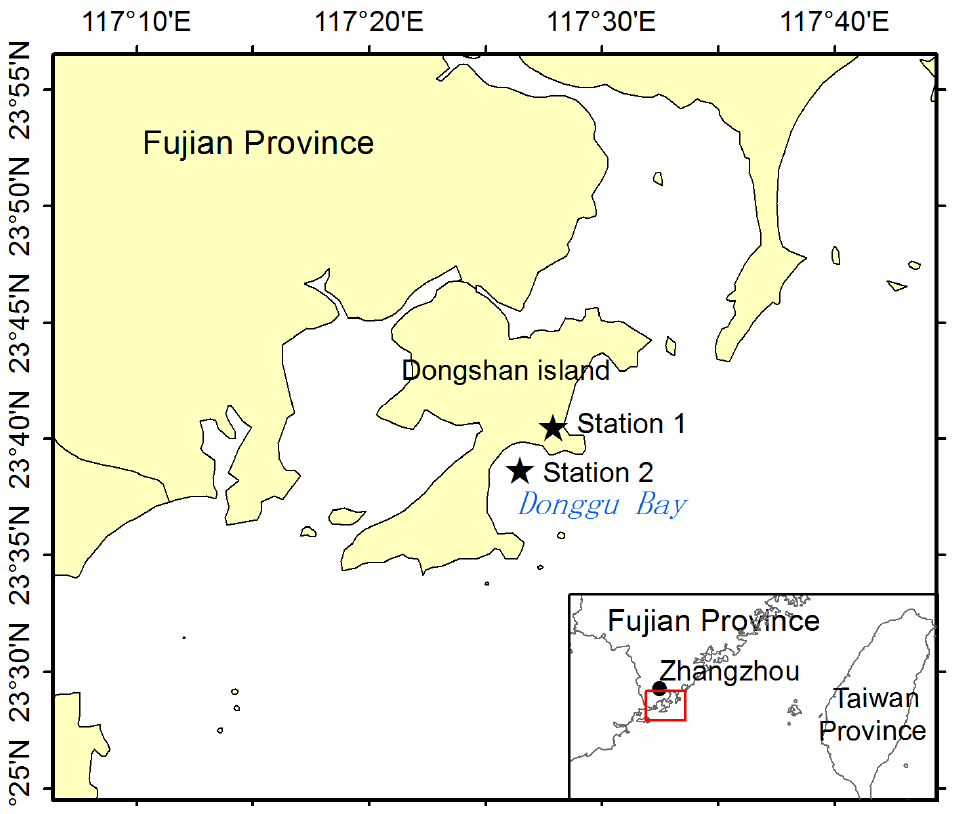
Figure 1. Sampling sites in Fujian Province.